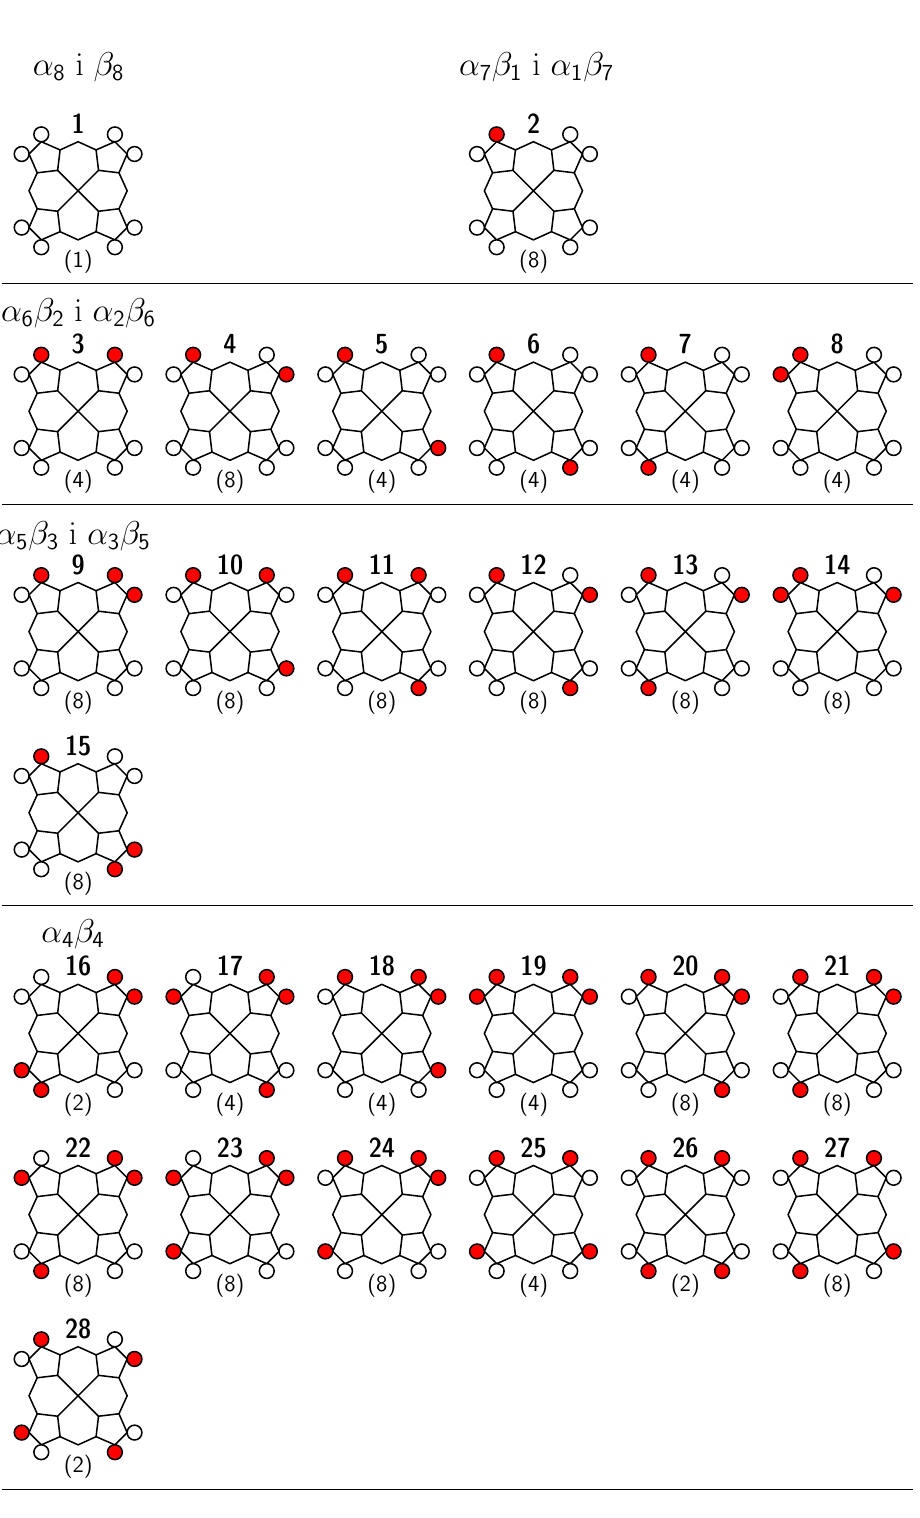
Figure 1 . The 28 unique conformers of Ni(OEP). Open (white) and closed (red) circles represent Et groups oriented above and below the mean plane of the porphyrin